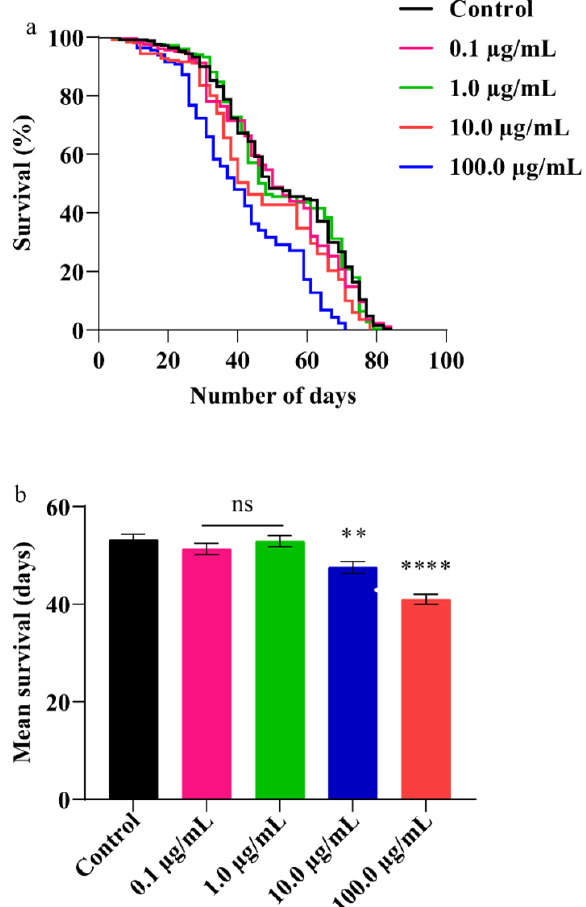
Figure 5. Survival assay: ( a ) Survival of flies in percentage ( b ) Mean survival of flies. Significance is ascribed as ns (non-significant),** p < 0.01, **** p < 0.0001 with respect to control.